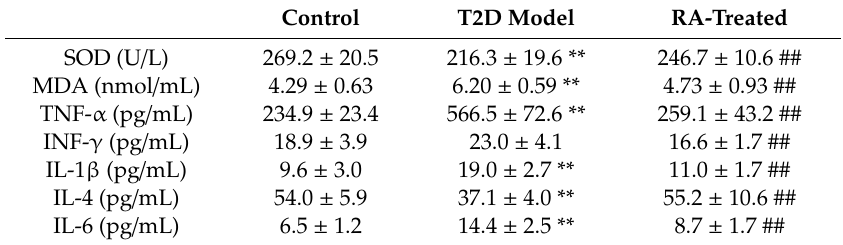
Table 2. Oxidative stress factors (SOD, MDA) and cytokines (TNF- α , INF- γ , IL-1 β , IL-4, and IL-6) of the control group, T2D model group and RA-treated group (40 mg / kg / day) at the end of the